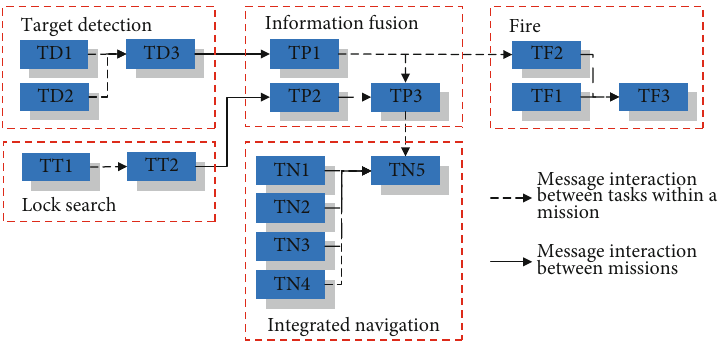
Figure 6: An example of the hierarchical task model: attack mission